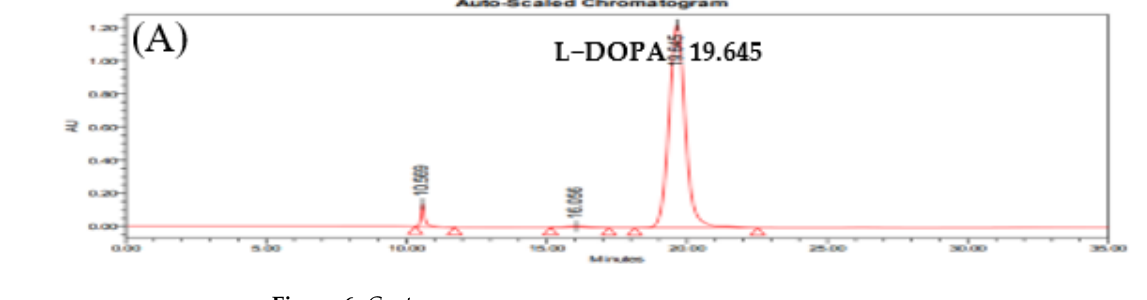
Figure 6. UPLC for identification of L-DOPA in M. pruriens extracts at 210 nm. ( A ) Standard mate- rial, ( B ) MW, ( C ) ME, and ( D ) MA. 3. Materials and Methods 3.1. Preparation of Mucuna Pruriens Extract The M. pruriens used in this study was purchased from Mirae Farming (Gyeonggido, Korea). To extract M. pruriens with hot water (MW), 100 g of crushed M. pruriens was placed into an Erlenmeyer flask and, after applying distilled water corresponding to ap- proximately 10 times the specimen weight, the process of double boiling for 3 h in a 99 °C water bath was repeated in triplicate. To produce M. pruriens extracts with 70% ethanol (ME) and 70% acetone (MA), 100 g of crushed M. pruriens was placed into an Erlenmeyer flask; after immersing the equivalent to about 10 times the specimen weight in either 70% ethanol or 70% acetone, the process of extraction for 24 h at room temperature was re- peated in triplicate. Then, each extract was filtered using filter paper (No. 20 filter paper; Hyundai Micro Co., Ltd., Seoul, Korea), concentrated under reduced pressure, and freeze-dried to produce powdery extract specimens of M. pruriens . The yields of MW,